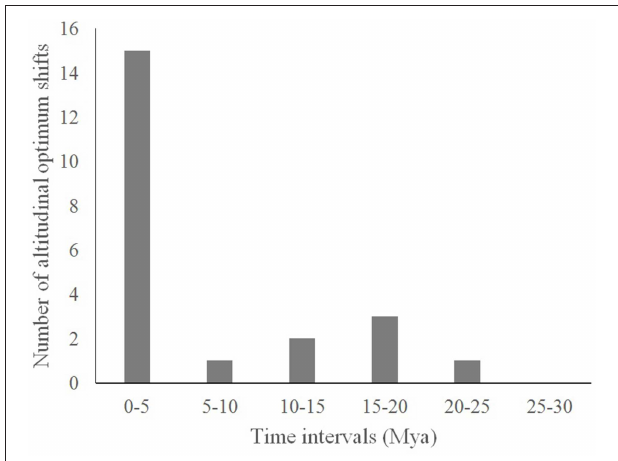
FIGURE 3 | Number of altitudinal optimum shifts per 5 million years intervals, as identified using the “surface” R